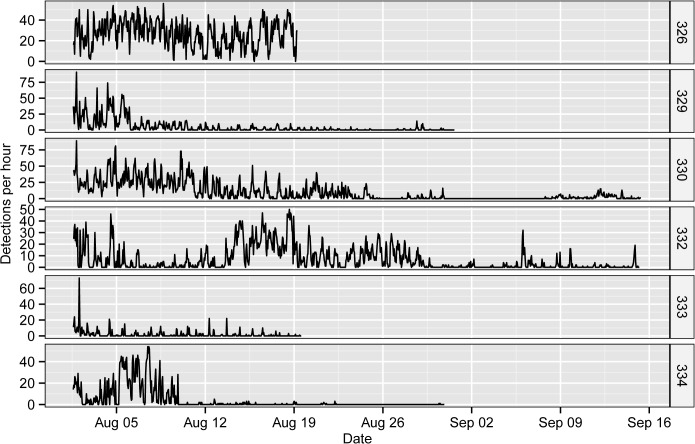
Chronograms of the hourly detections (pooled from all receivers) of the six tagged S. schlegelii.